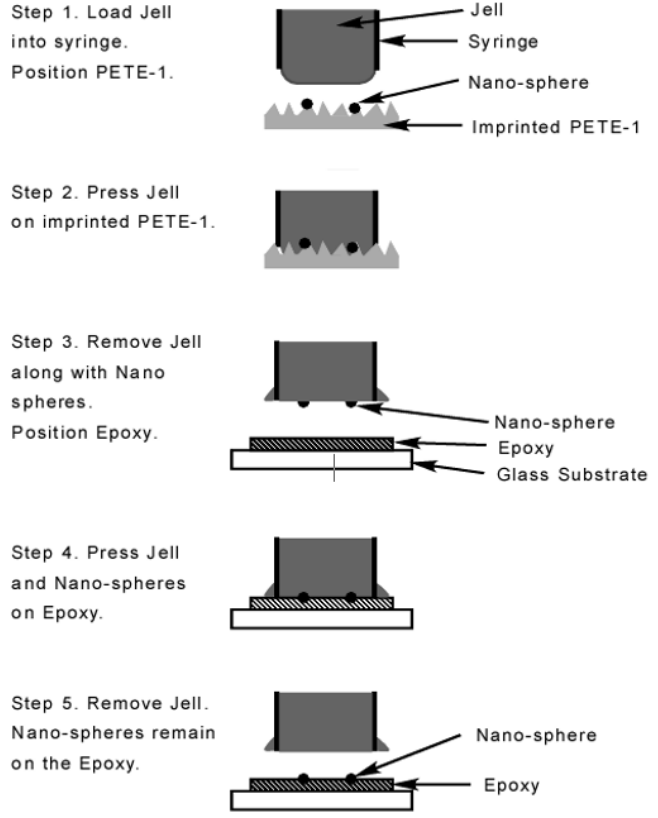
Figure 5. Schematic flowchart of the transfer process. Portions enlarged for clarity.